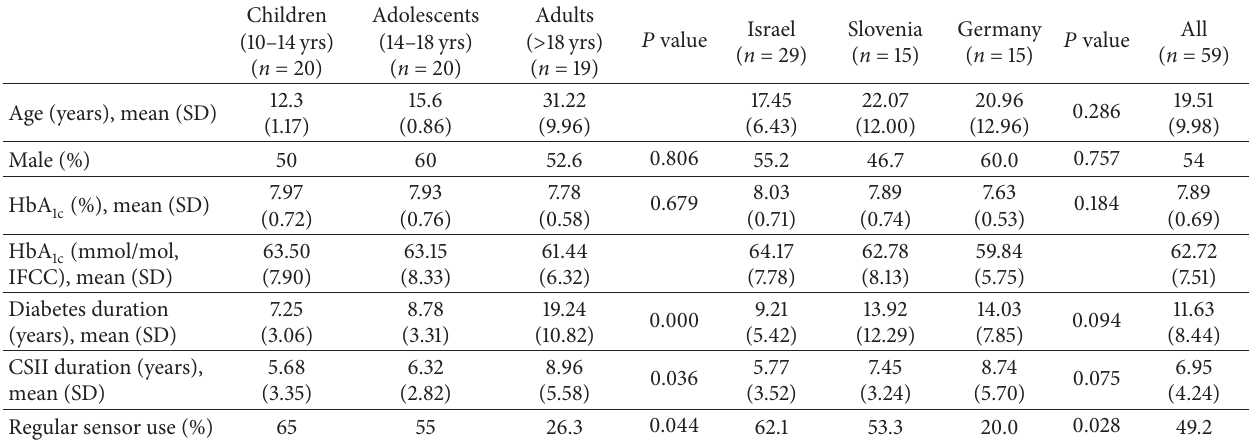
Table 1: Baseline patient